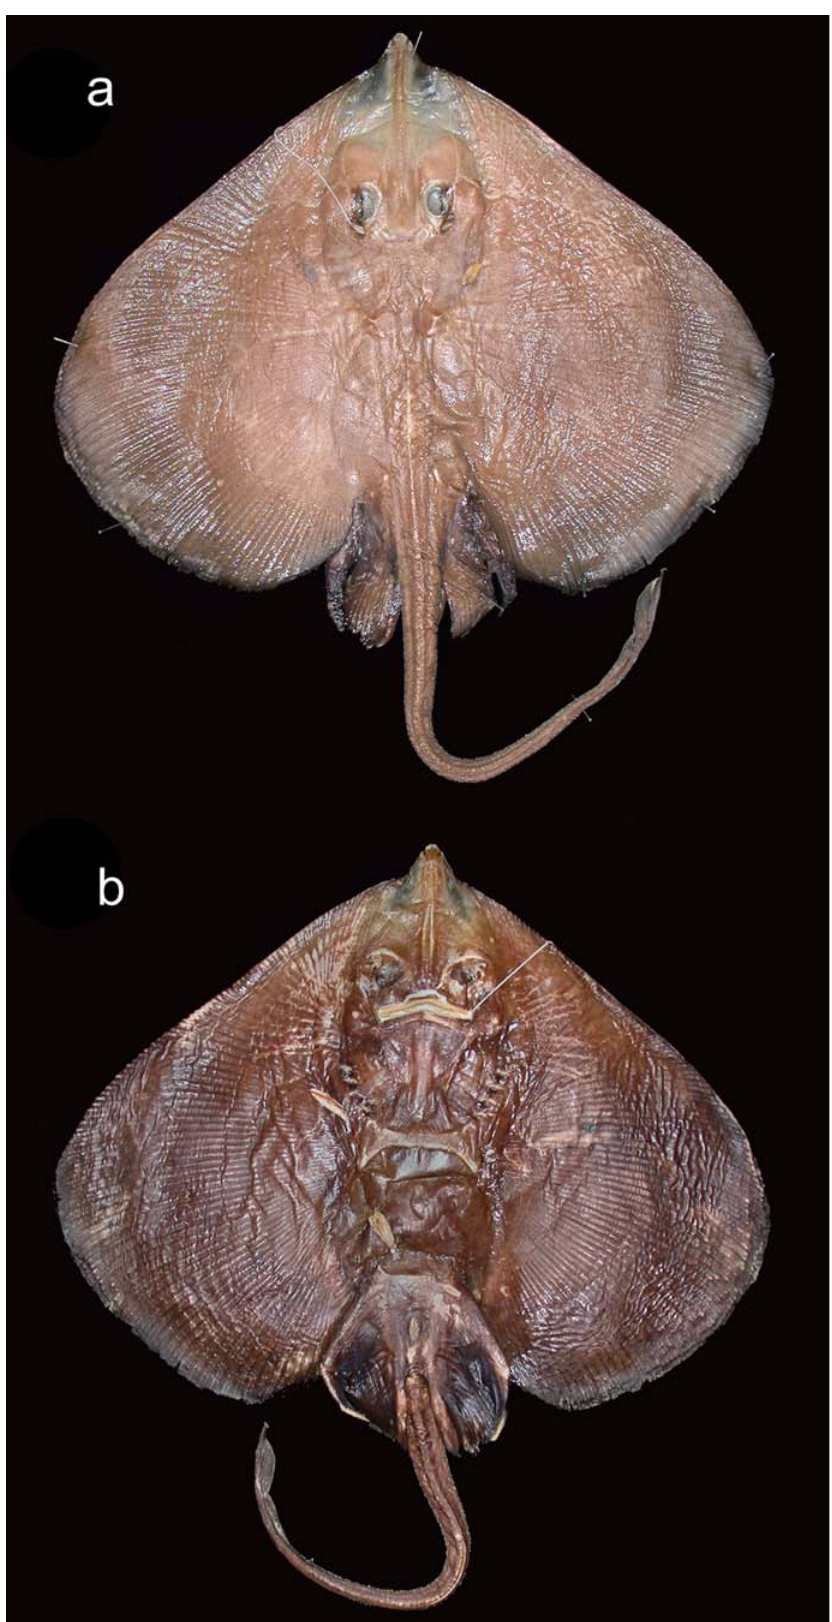
Fig. 2. Larger male paratype of Malacoraja obscura , n. sp. (MNRJ 28290, 505 mm TL) in dorsal (a) and ventral (b)